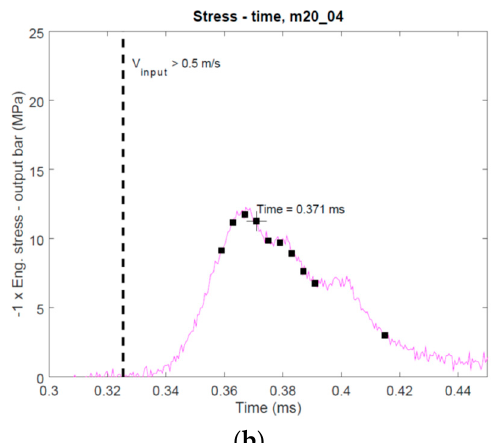
Figure A3. ( a ) processed high speed footage obtained in the high rate test m20_04, ( b ) corresponding specimen stress-time signal obtained from the output bar strain gauge measurement (synchronized with high speed footage). The input bar is located on the left-hand side of the figure in ( a ). The time, at which the input bar end velocity exceeded 0.5 m / s as well as the times corresponding to the high speed frames are marked on the respective stress-time curve.